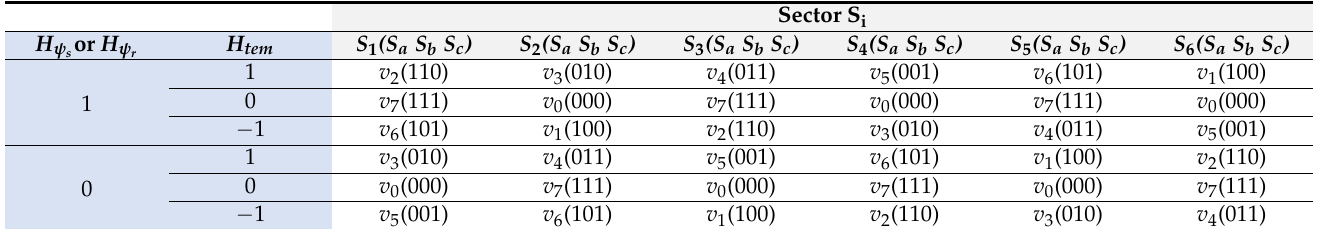
Table 1. Voltage vector